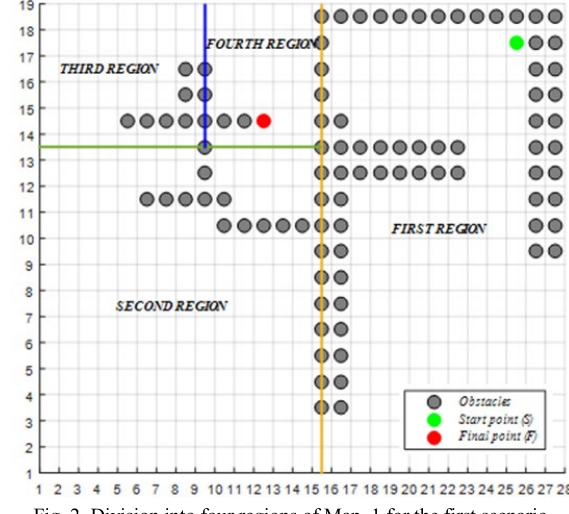
Fig. 2. Division into four regions of Map_1 for the first scenario. Definition 2: Determining S and F of each